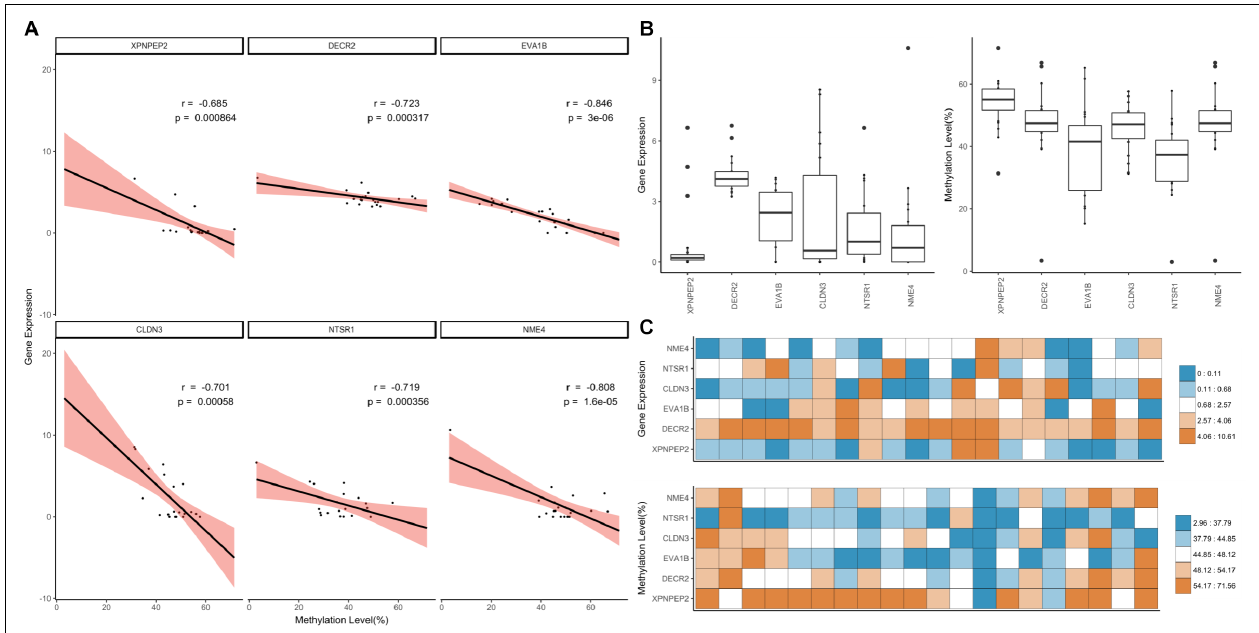
FIGURE 6 | Downstream genes of highly significant GSMs. (A) Correlation of the highly significant GSMs and distribution of DNA methylation and gene expression values. The simple linear correlation and 95% confidence intervals marked using the lm function (black line, red range). (B) Distribution of gene expression and DNA methylation values was expressed using boxplot. (C) Heatmap of gene expression and DNA methylation values.